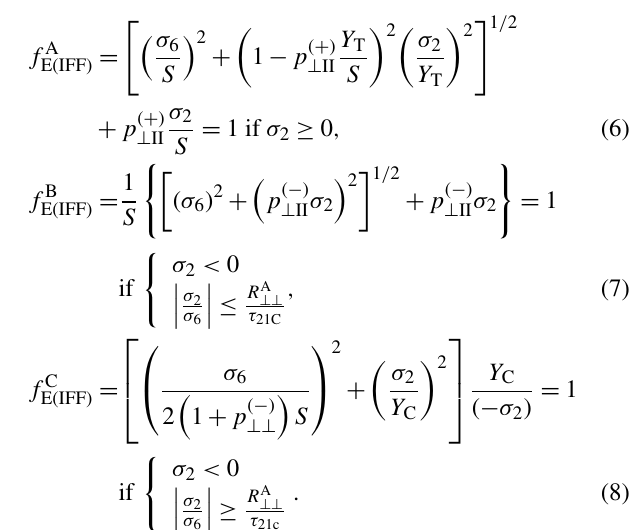
Table 1. Degradation rules according to the failure